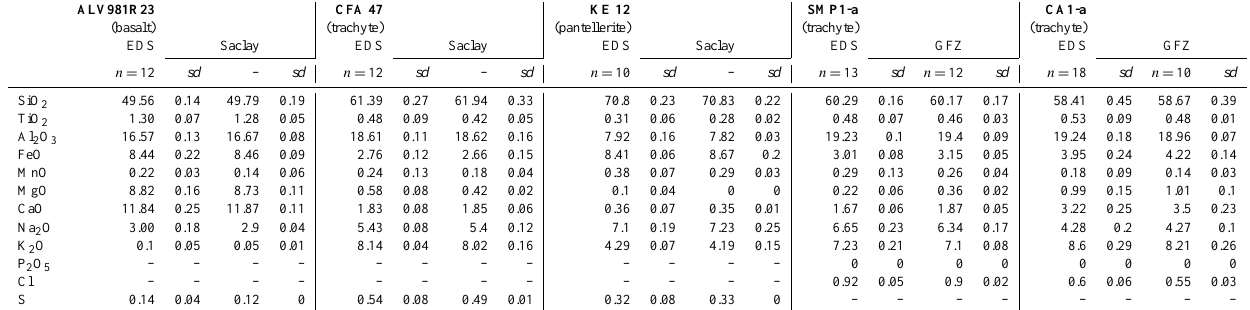
Table 1. Comparison of the EDS device used in this study in comparison with WDS microprobes from GeoForschungsZentrum (GFZ, Potsdam, Germany), and from Saclay (France; Cioni et al., 1998). Reference material comprises volcanic glasses with a chemistry ranging from basalt to trachyte. ALV981R23, CFA47, and KE12 samples from Cioni et al. (1998).